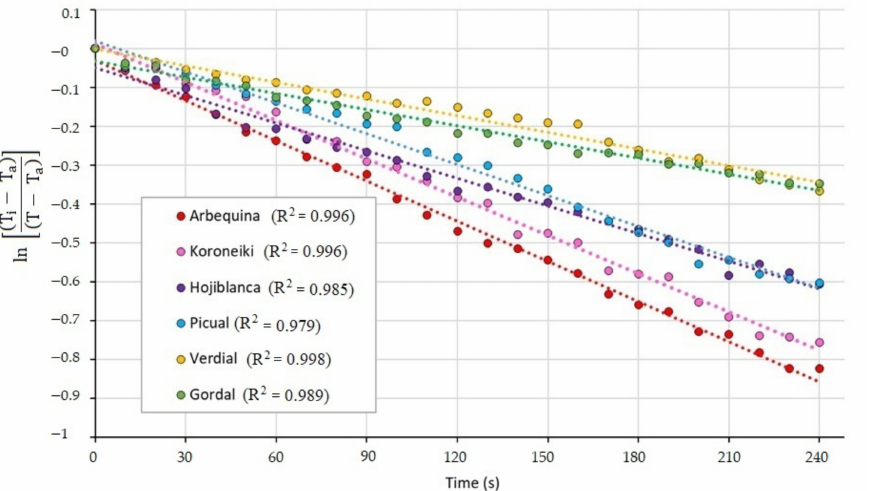
Figure 3. Semi-logarithmic cooling rate curve of 6 different samples of olives. Each point represents the mean of 25 residual temperature ratios.